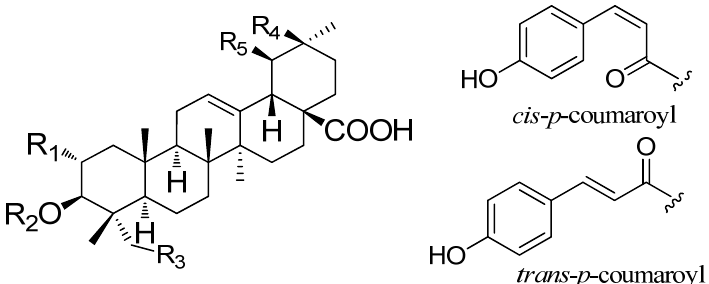
Figure 1. Chemical structures of nine triterpenoids from P. guajava .